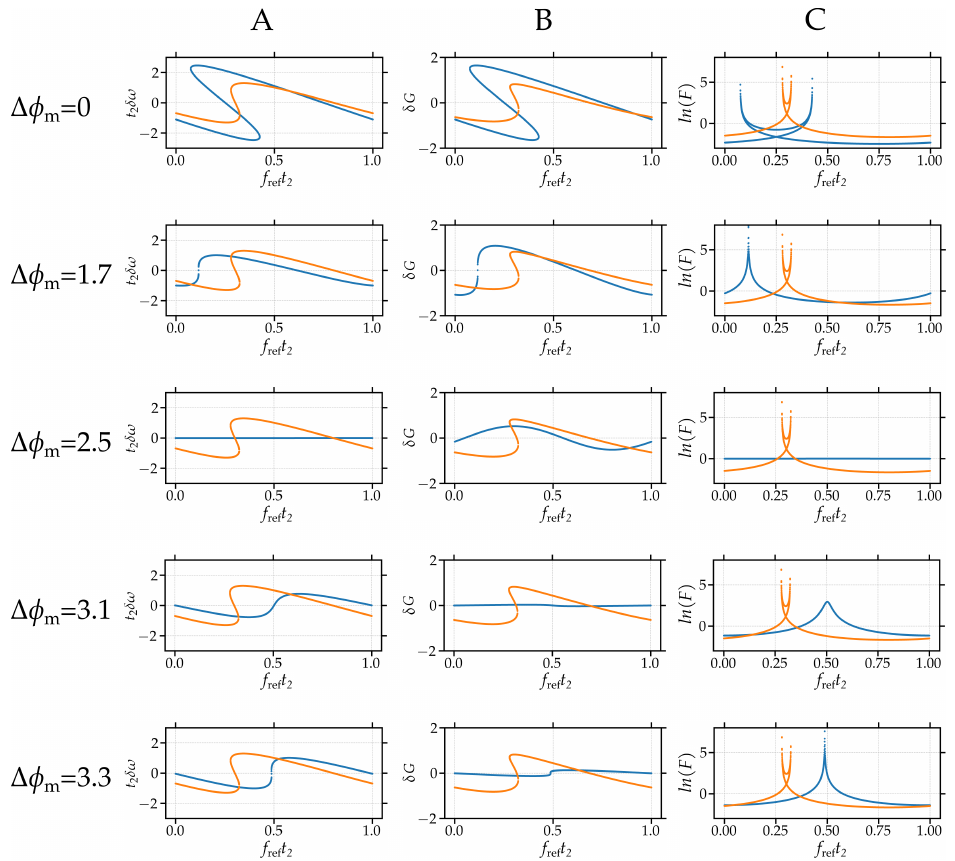
Figure 4. Numerical solutions for C = 1.3 under conditions (8) and (11) for different ∆ φ m . Double- feedback case shown in blue, single feedback case shown in orange. Column ( A ) shows the lasing frequency shift results. Column ( B ) shows the threshold gain shift. Column ( C ) shows the intrinsic linewidth